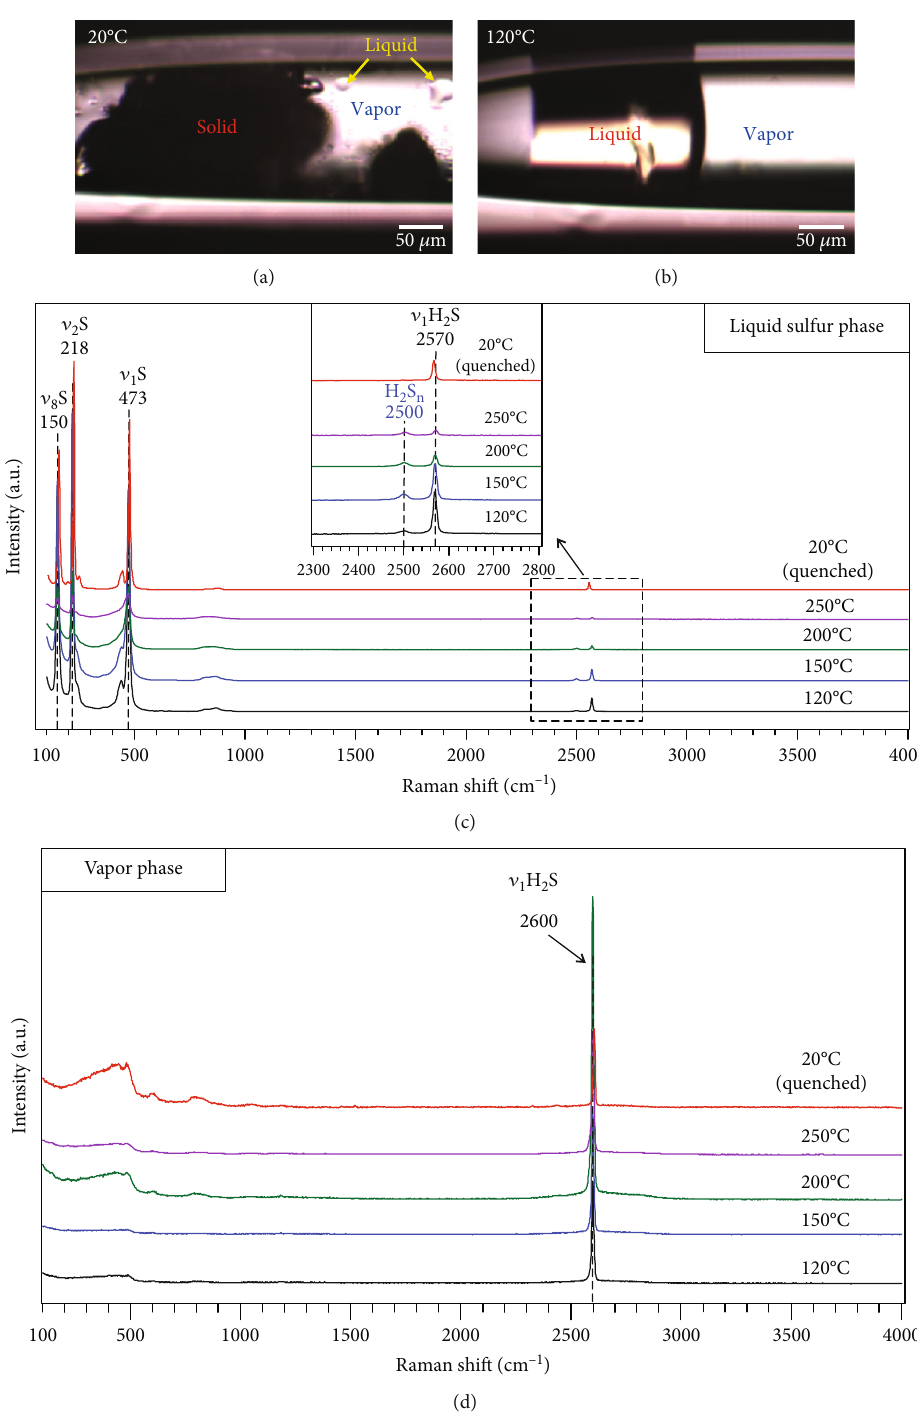
Figure 3: Phase behavior (a and b) and in situ Raman spectra (c and d) of the S – H H S coexisted at 20 ° C; (b) vapor H S and liquid S coexisted at 120 ° C; (c) full window in situ Raman spectra of the liquid S at 120 – 250 ° C and 2 2 the spectra of the quenched solid S at 20 ° C; spectra of the 2300 – 2800cm − 1 region are magni fi ed and (d) in situ (120 – 250 ° C) and quenched (20 ° C) Raman spectra of the vapor